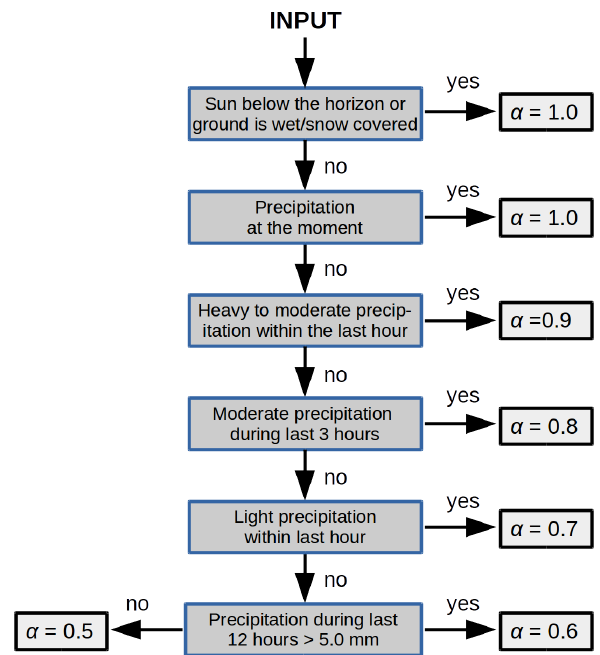
Figure B1. Flow chart of how the Priestley–Taylor moisture param- eter ( α ) is estimated from input parameters that comprise state of the ground, current weather, weather during the last hour, weather during the last 3h, precipitation during last 12h, and solar elevation